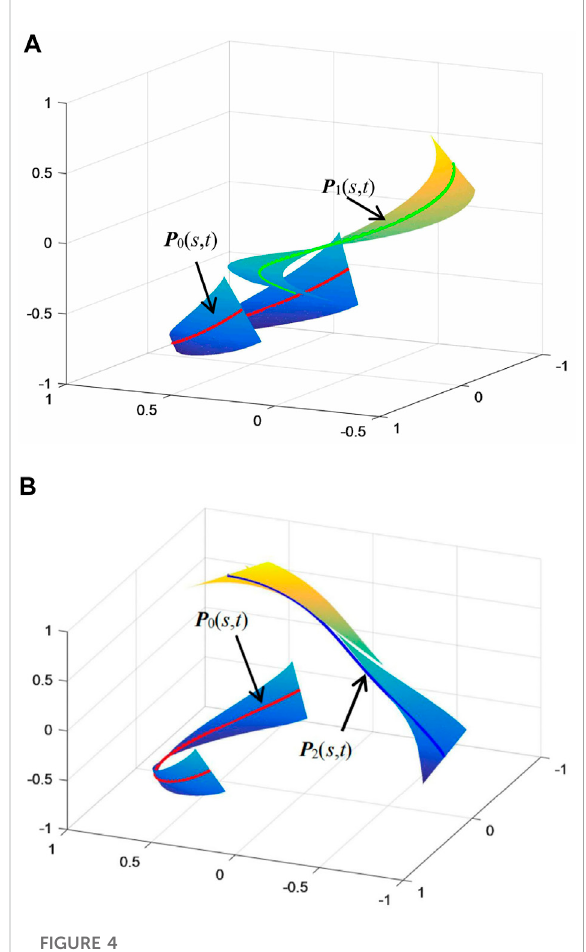
FIGURE 4 { P 0 ( s, t ) , P i ( s, t ) } interpolating { R 0 (s), R i (s)}, ( i = 1, 2 ) as common D-type